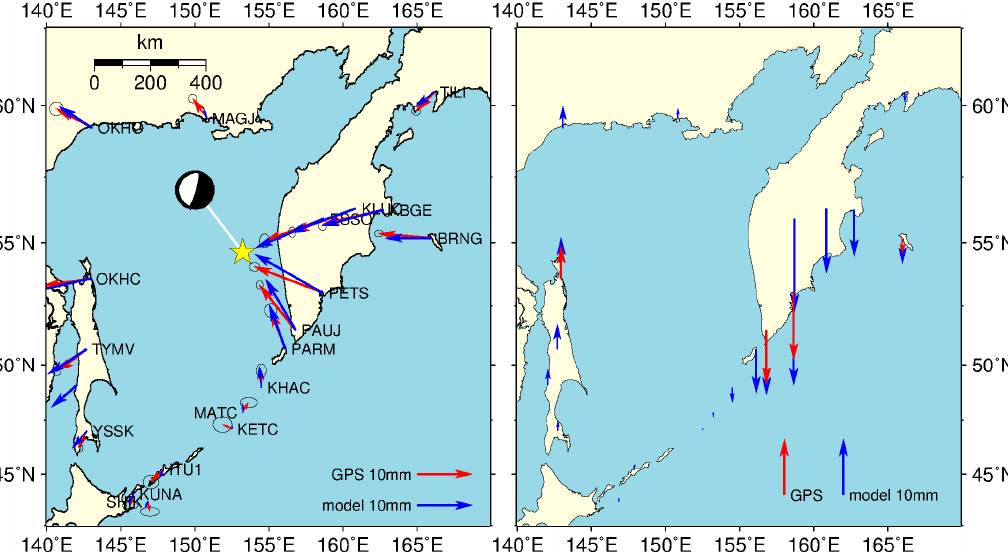
Figure 6. Theoretical and observed coseismic deformations. Horizontal displacement is shown in the ( left plot ), and vertical displacement is shown in the ( right plot ). The red arrows represent the Global Positioning System (GPS) results [22], and the blue arrows represent the simulated results.